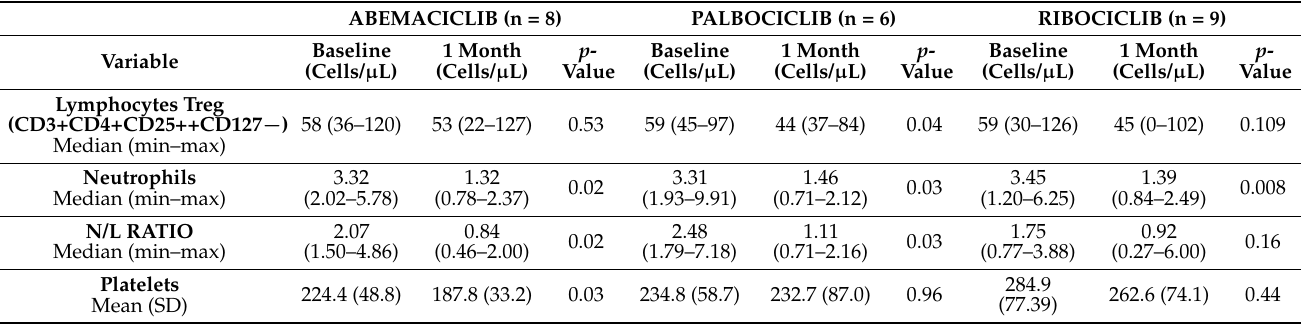
Table 3. Comparison of values between baseline and after 1 month of therapy according to the type of